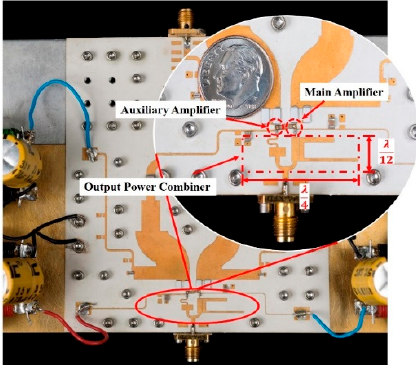
Figure 15. Photo of the fabricated Doherty Amplifier.